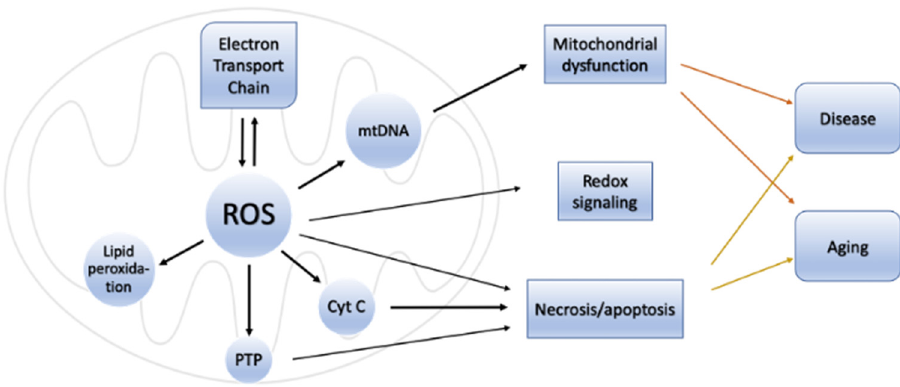
Figure 1. Effects of ROS production by mitochondria. The generation of ROS as a by-product of cellular respiration via the electron transport chain in mitochondria can have deleterious effects in the cell and tissue involved. ROS can cause oxidative damage to mitochondrial DNA and protein, resulting in mutations and mitochondrial dysfunction that impair the ability of mitochondria to synthesize ATP, leading to disease. Reactive species can also lead to the induction of a permeability transition pore (PTP) in mitochondria, rendering the inner membrane of the mitochondria more permeable to small molecules during episodes of ischemia/reperfusion injury. ROS can also lead to the oxidative degradation of lipid molecules (lipid peroxidation), especially within the cell membrane, resulting in cell damage and death. Reactive species can also lead to the release of intermembrane proteins including cytochrome c (Cyt C) into the cytosol of the cell, which, in turn, can activate apoptotic machinery within a cell, leading to cell death.